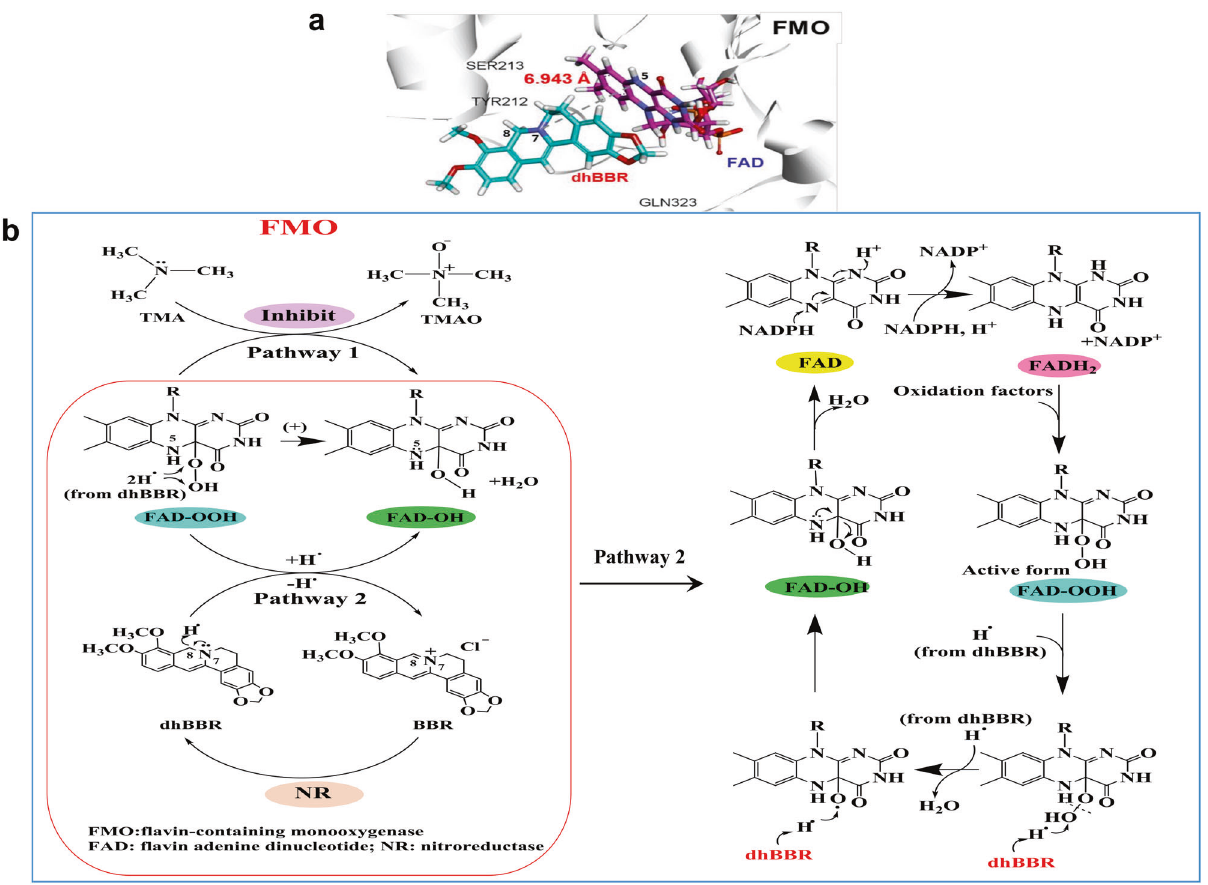
Fig. 3 Putative mechanisms of dhBBR on inhibiting bacterial fl avin-containing monooxygenase (FMO). a The virtual docking of dhBBR with bacterial FMO by CDOCKER tools and the possible interactions. b BBR might inhibit TMAO production through dhBBR ’ s inhibitory activity on FMO in the gut